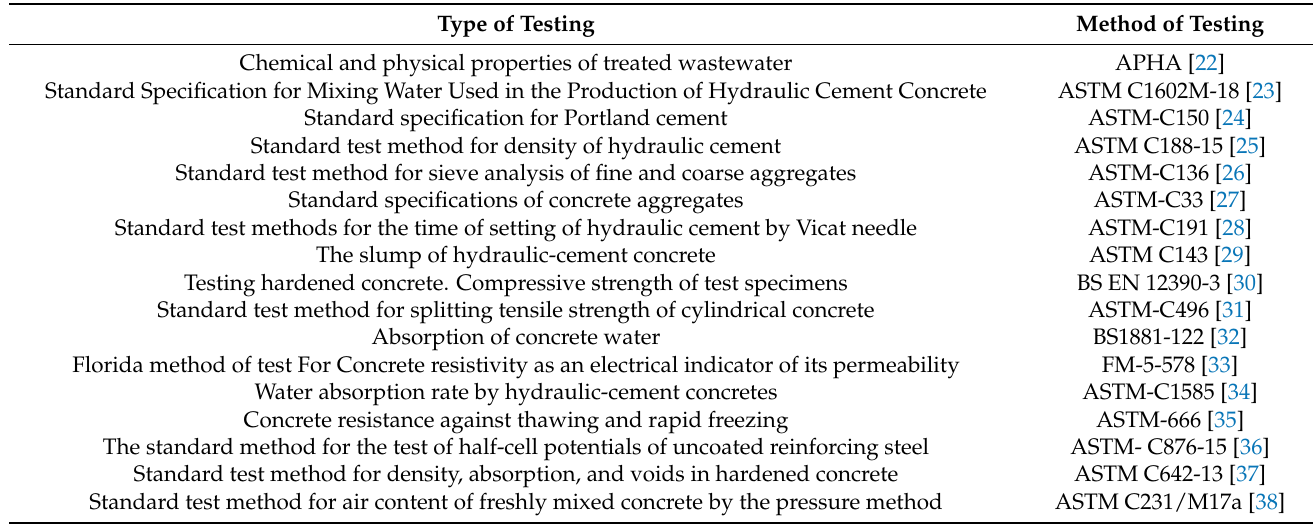
Table 1. The types of testing and the corresponding